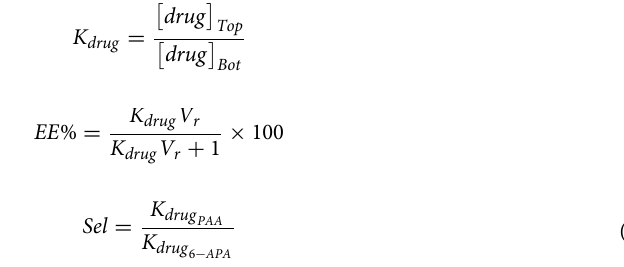
where and V r represent the concentration of drug and the volume ratio between top and bottom phases. Phenyl acetic acid (PAA) and 6-aminopenicillanic acid (6-APA) were determined by UV Spectroscopy at 254 and 207 nm, respectively, using previously determined calibration curves. In order to eliminate the interference of phase forming components, ternary mixtures at specific concentrations of each component were prepared, using pure water instead of the aqueous solutions of drugs, to be used as blank solution. Three replicates were prepared for each assay, the results were reported as average of triplicated calculated partition coefficient. In order to study the partition coefficient in system contains both 6-APA and PAA, HPLC has been applied. The HPLC procedure is explained in ref. 21 . Effect of temperature on partitioning. To study the effect of temperature on partitioning of PAA, 4 different temperature were selected (4, 15, 25 and 40 °C). According to Eqs. 11–13, thermodynamic parameters of the partitioning of PAA can be